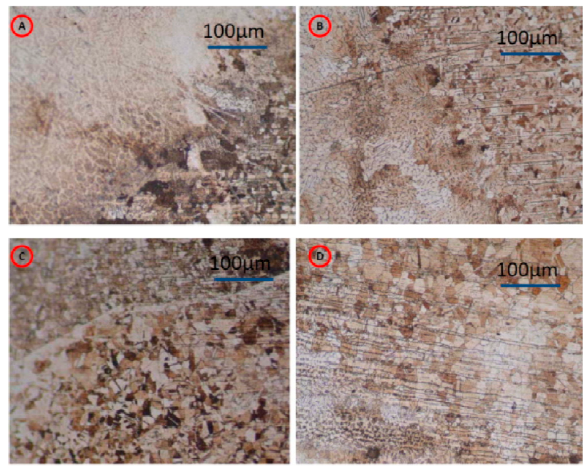
Figure 2. Microstructure of the weld made in conventional atmosphere, ×100. Interface weld zone—thermally affected zone (WZ-TAZ): ( A ) not irradiated; ( B ) at 200 Gy; ( C ) at 700 Gy; ( D ) at 1000 Gy.